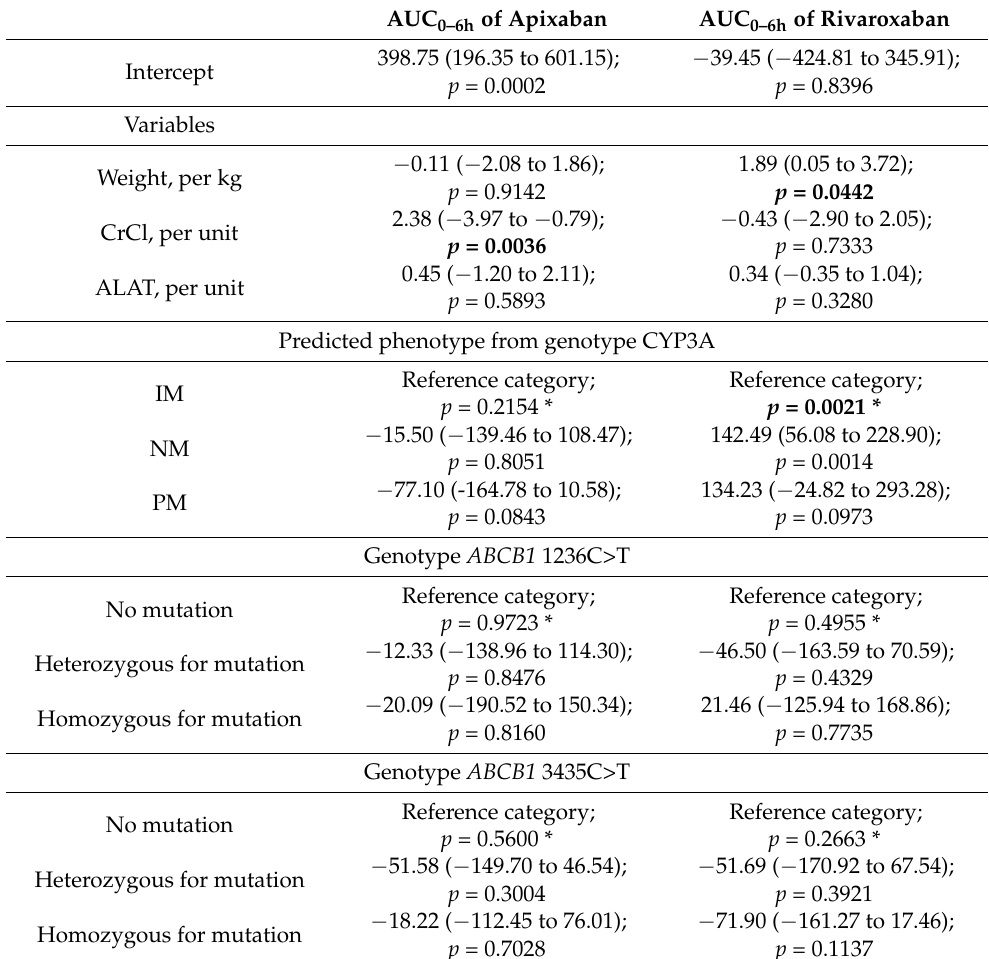
Table 4. Multivariable linear regression models to assess whether the genotype of CYP3A and P-gp are associated with the AUC 0–6h of apixaban and rivaroxaban. Each independent variable is reported with its beta coefficient ( β ) and its 95% confidence interval